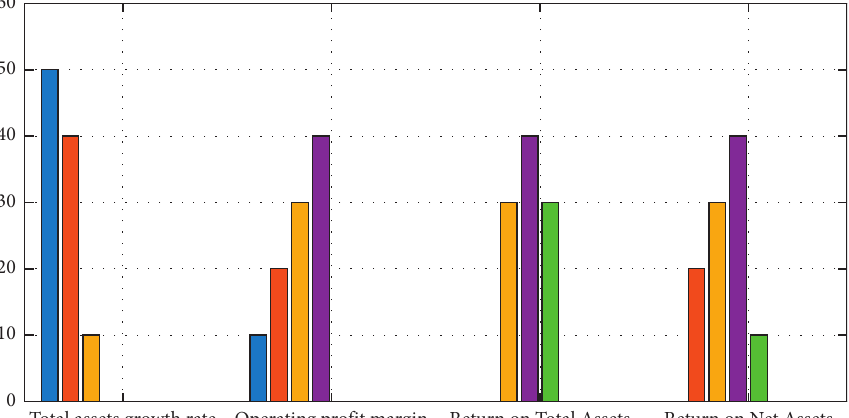
Figure 5: Histogram of investment risk indicator score